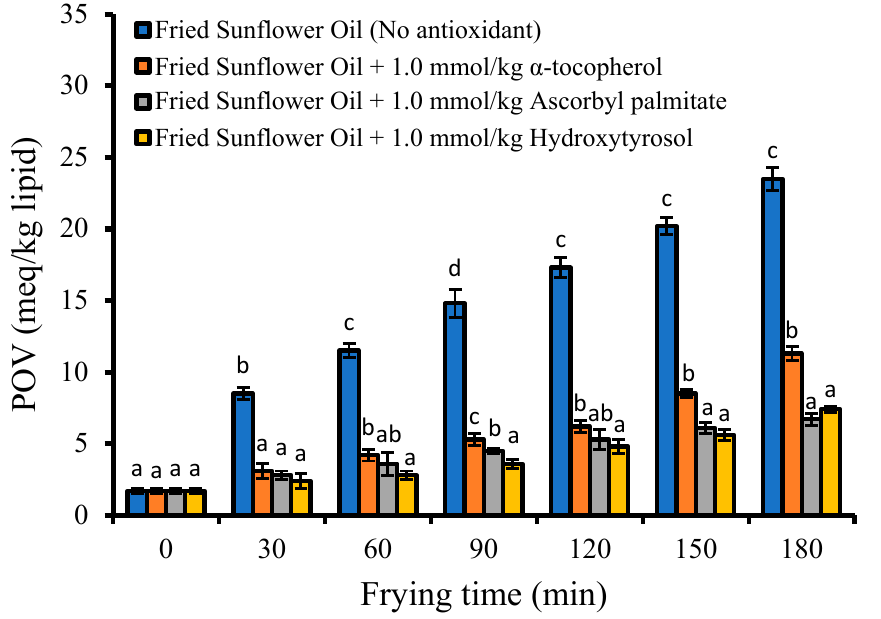
Figure 2. The stability of antioxidants in sunflower oil (SFO) over an extended frying period. Values are expressed as mean ± standard deviation ( n = 3). Bars not sharing a common letter are significantly different ( p < 0.05) within each treatment.